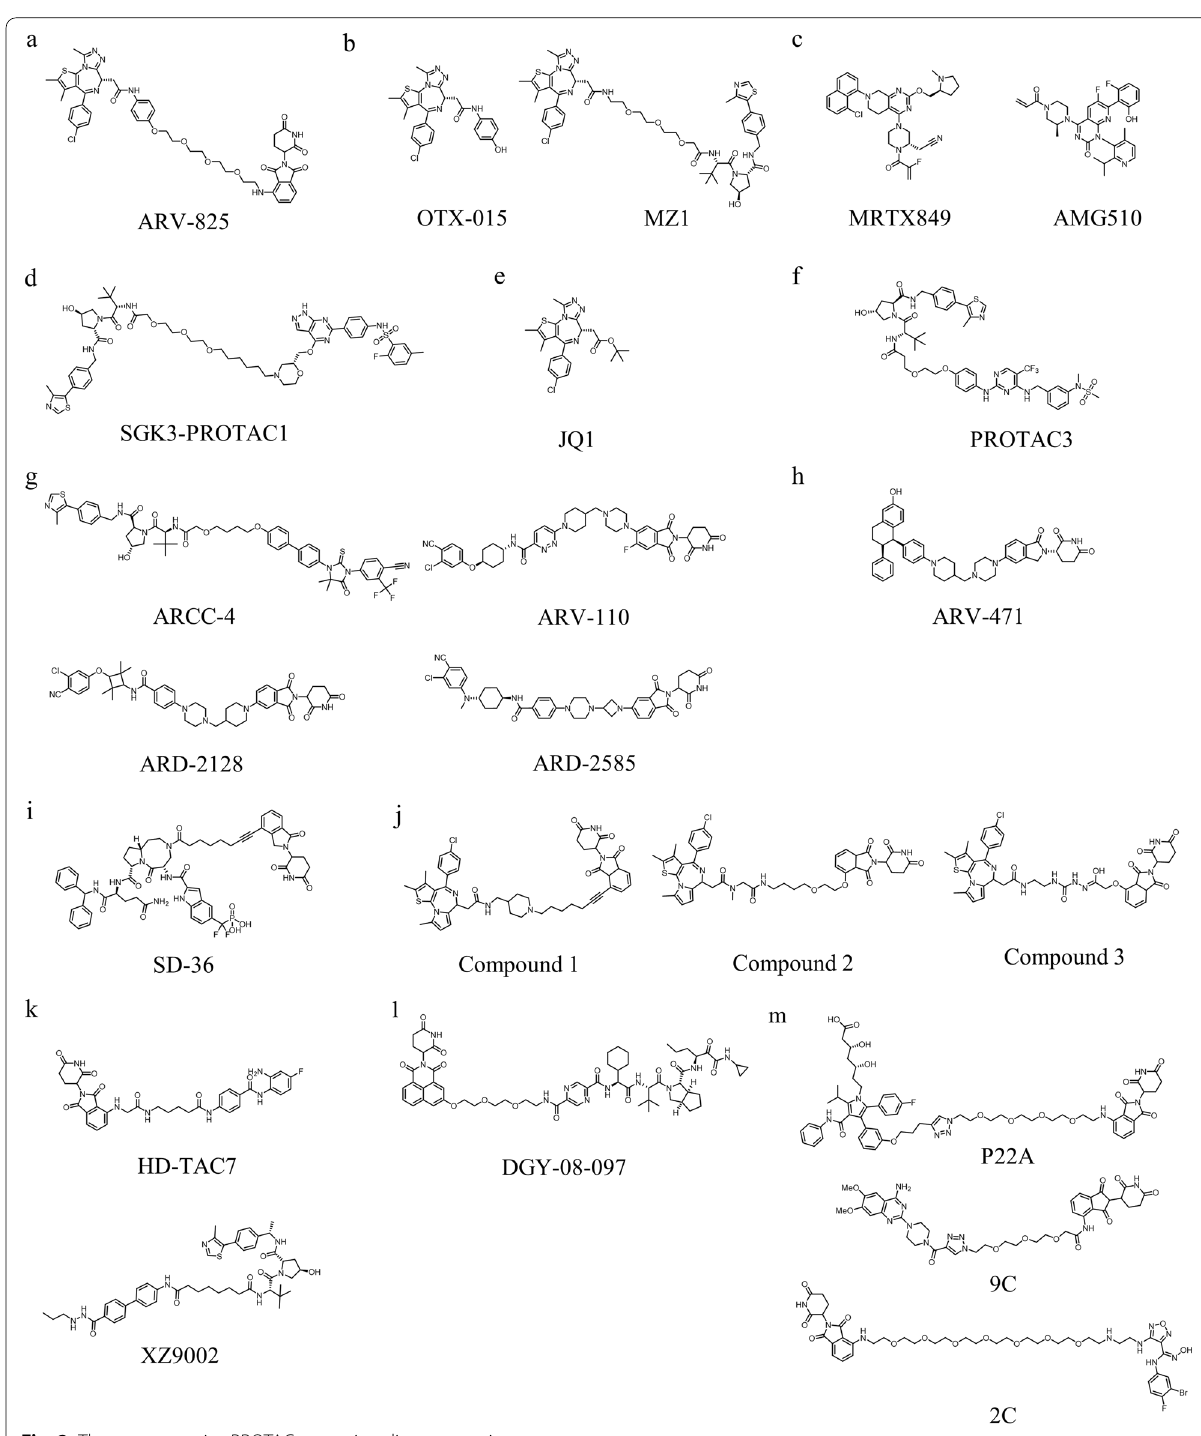
Fig. 2 The representative PROTACs targeting diverse